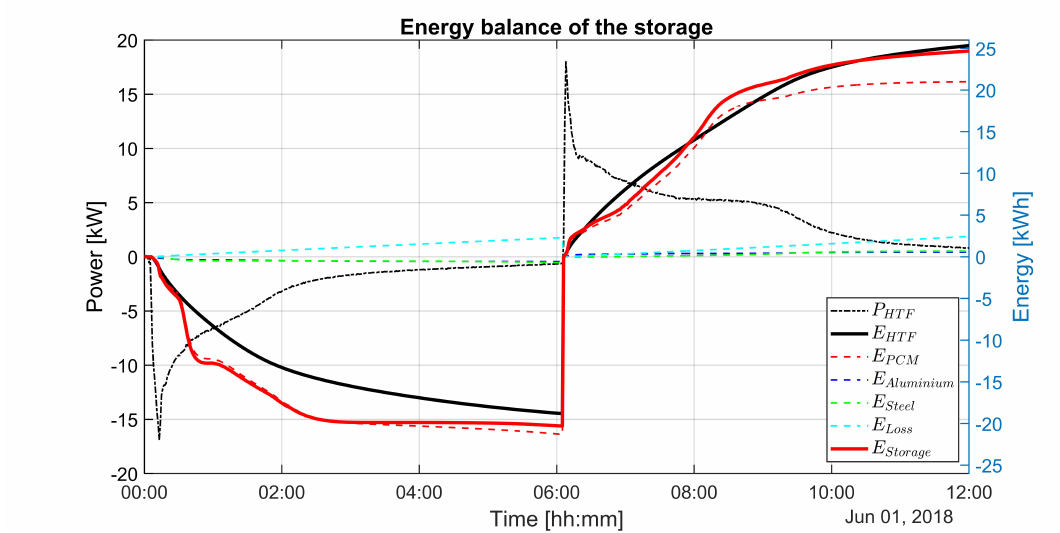
Figure 12. Energy